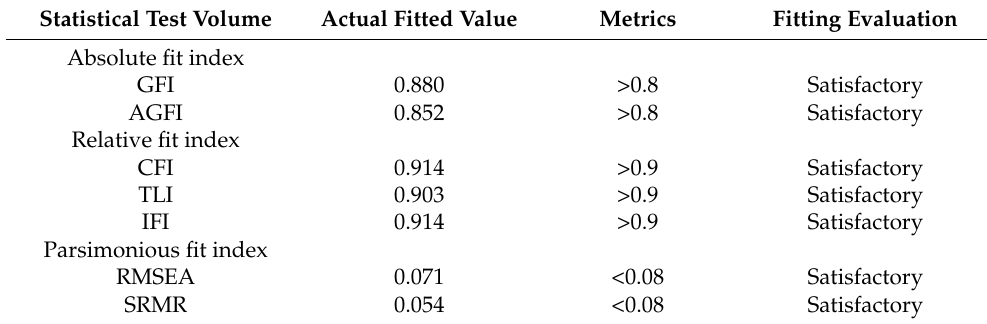
Table 5. Model goodness-of-fit tests.